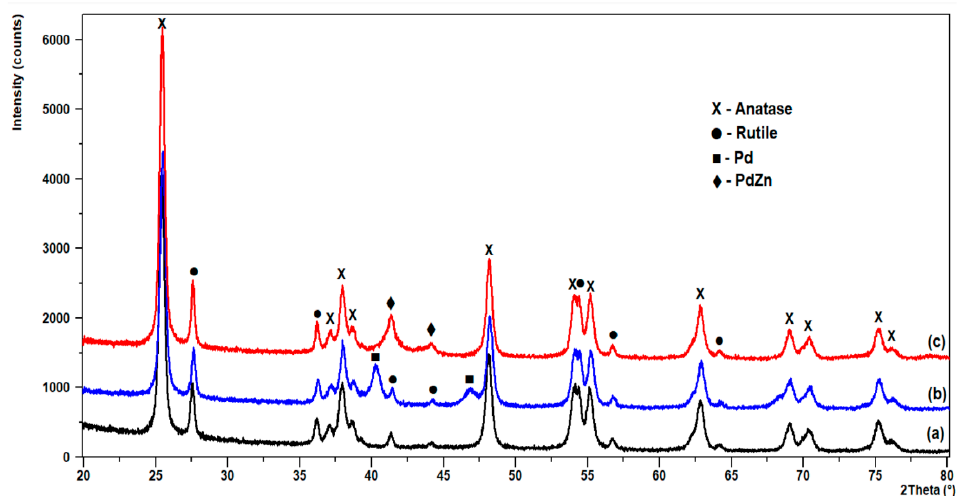
at 9 nm. Figure 7. XRD patterns of model catalysts: (a) 2.5%Zn/TiO 2 ; (b) 5%Pd/TiO 2 ; (c) 2.5%Zn/5%Pd/TiO 2 .